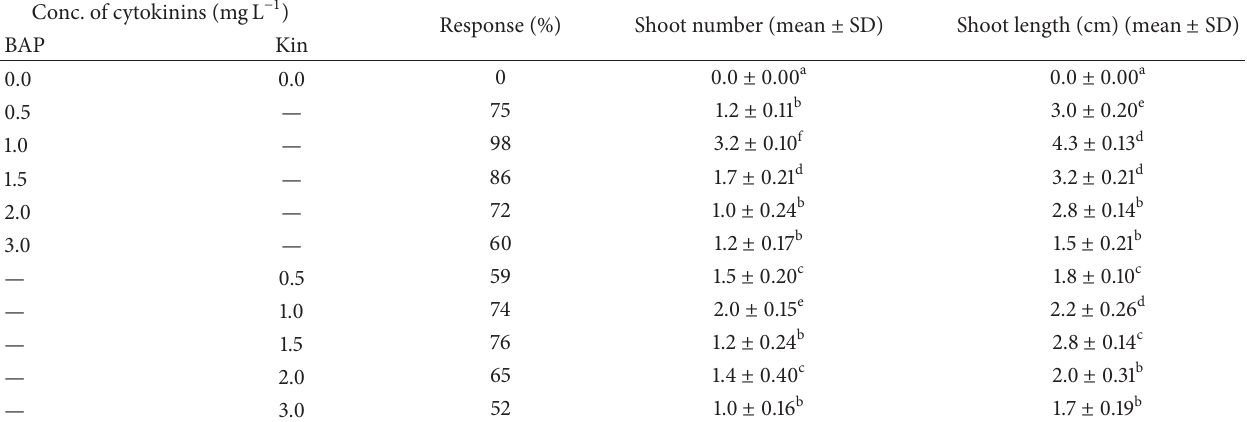
Table 1: Effect of cytokinins on induction of shoots from nodal segments of R. pectinata . Conc. of cytokinins (mg L −1 )